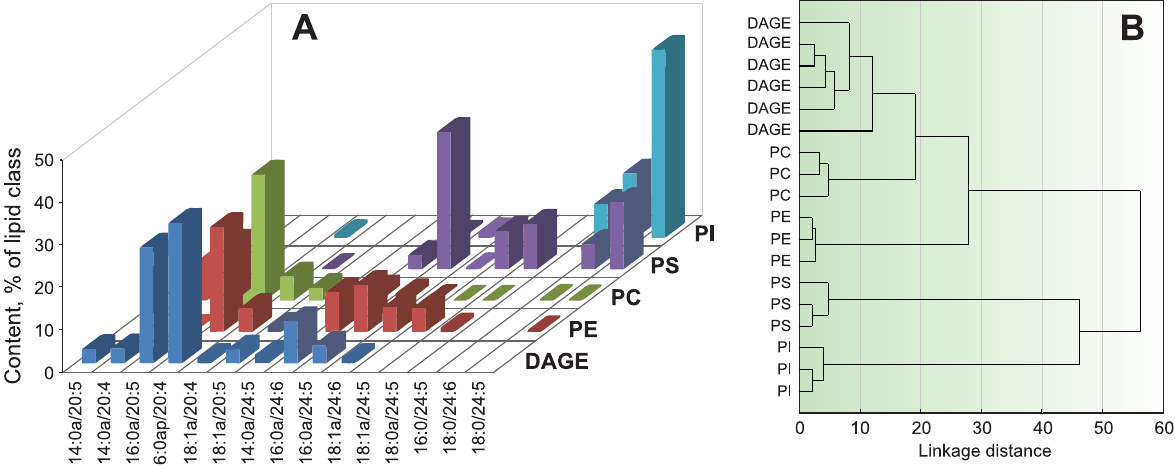
Figure 2. Comparison of non-polar parts of GPL and DAGE. ( A ) Profiles (% of lipid class) of 1- O -alkyl- 2-acyl parts of glycerophospholipid (GPL) and diacylglycerol ether (DAGE) molecular species in the soft coral Paragorgia arborea . ( B ) A dendrogram of cluster analysis of 6 samples of DAGE and 12 samples of four GPL classes by their 1- O -alkyl-2-acyl part composition. Ethanolamine, choline, inositol and serine GPL are abbreviated as PE, PC, PI, and PS, respectively; alkyl/acyl and diacyl forms, as Xa/Y and X/Y; Xa, alkyl group; X and Y, acyl groups (number of carbon atoms: number of double bonds). 16:0ap/20:4 is the sum of plasmanyl and plasmenyl